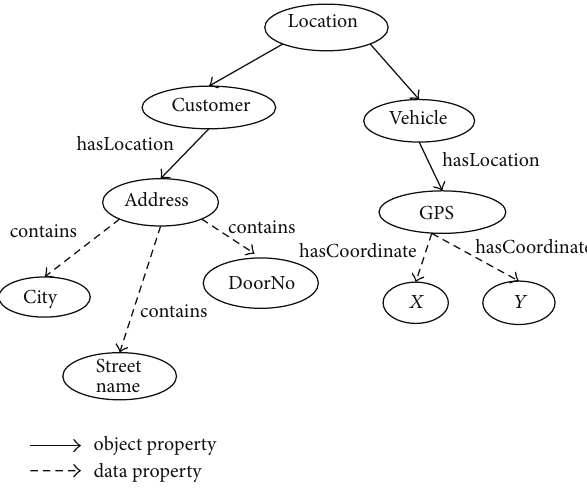
Figure 2: Location concept of the logistic